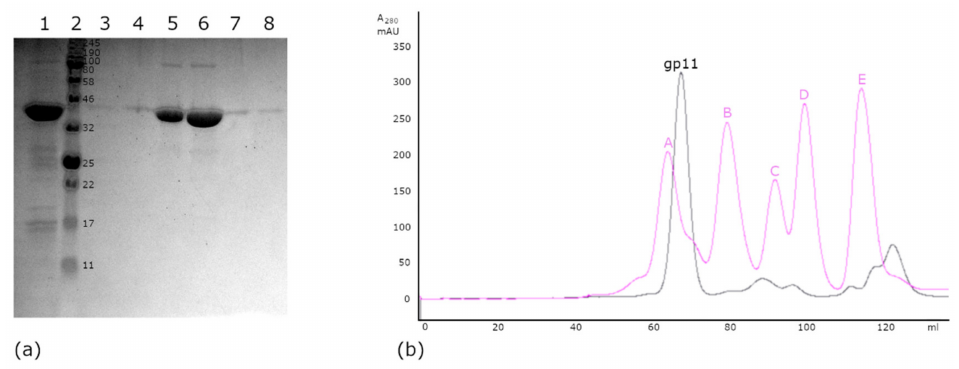
Figure 2. ( a ) SDS-PAGE gel from gel-filtration purification of gp11. Lane 1: starting material, concentrated protein from the metal-affinity column that was loaded onto the S200 column. Lane 2: molecular weight marker, with weights indicated in kilodaltons. Lanes 3–8: Sequential, 1.4 mL elution fractions of the single gp11 peak from the S200 column. Fractions 42 (58.8 mL)–47 (65.8 mL). ( b )Typical elution profile from a Superdex 200 (16/60) gel filtration column for gp11-containing fractions combined after metal-affinity purification. Magenta overlay is the elution profile of a standard protein mixture over the same flow rate conditions. The standards are (A) thyroglobulin (670 kDa); (B) γ -globulin (158 kDa); (C) ovalbumin (44 kDa); (D) myoglobin (17 kDa); and (E) vitamin B12 (1.35